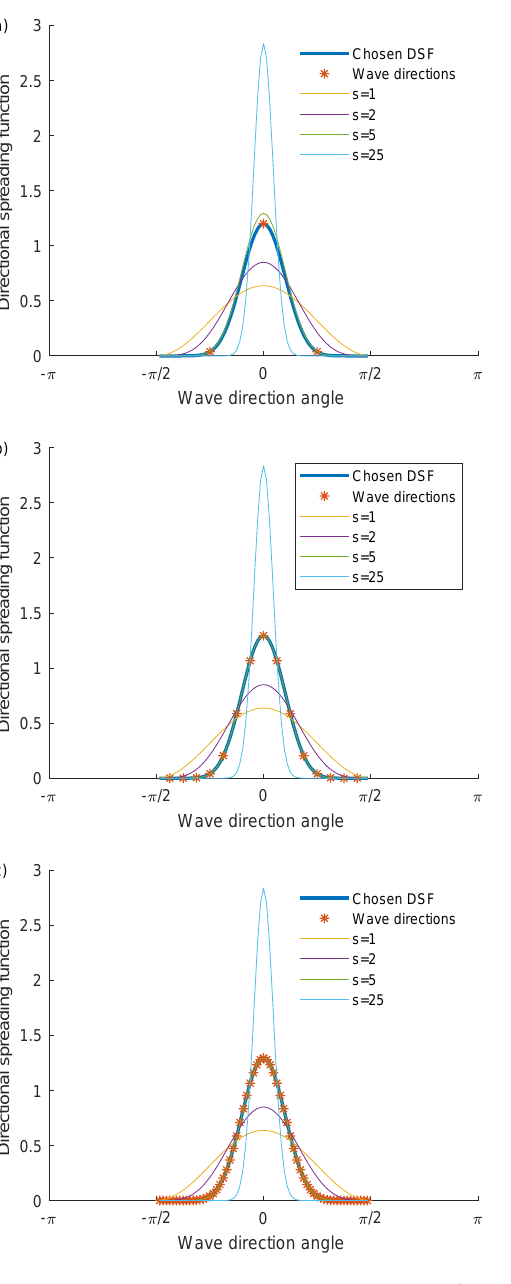
Figure 4. Directional spreading function D ( χ m − ¯ χ ) in Equation (21) for spreading parameter s = 5 increasing wave directions from 3, 15 and 63, as shown in the directional spreading function plots. A time instant of the surface elevation is shown to the right. ( a ) three wave directions χ m = ± m π /4 with m = 0,1; ( b ) 15 wave directions χ m = ± m π /16 with m = 0, . . . ,7; ( c ) 63 wave directions χ m = ± m π /64 with m = 0, . . .